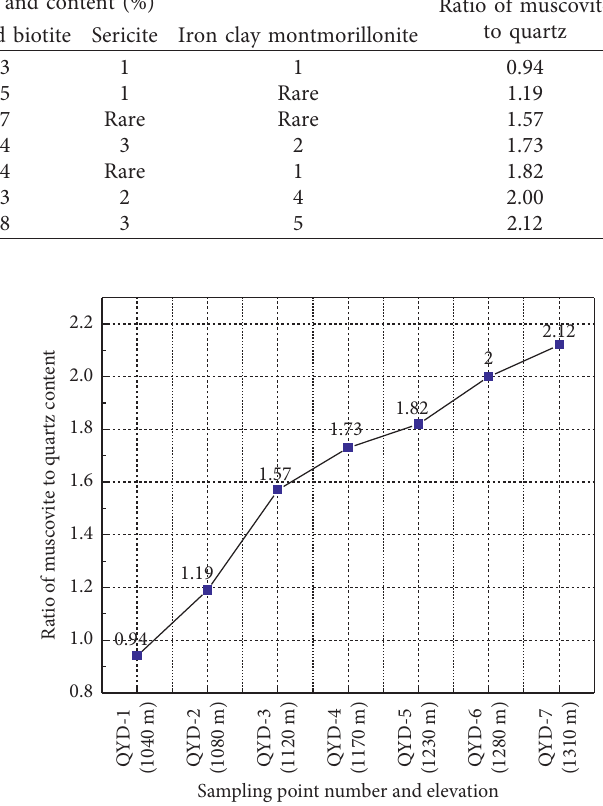
Figure 7: The ratio curve of mica and quartz content at different elevation sampling